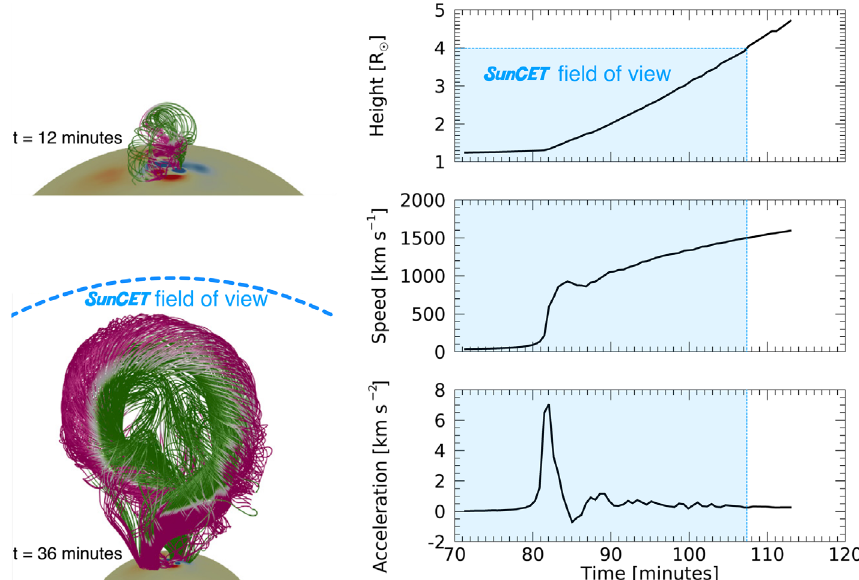
Fig. 4. MFE simulation containing the helical kink instability, resulting in impulsive CME acceleration. The SunCET FOV (0 – 4 R (cid:1) ; indicated in light blue) captures the impulse and small jerks. Adapted from Fan (2016).